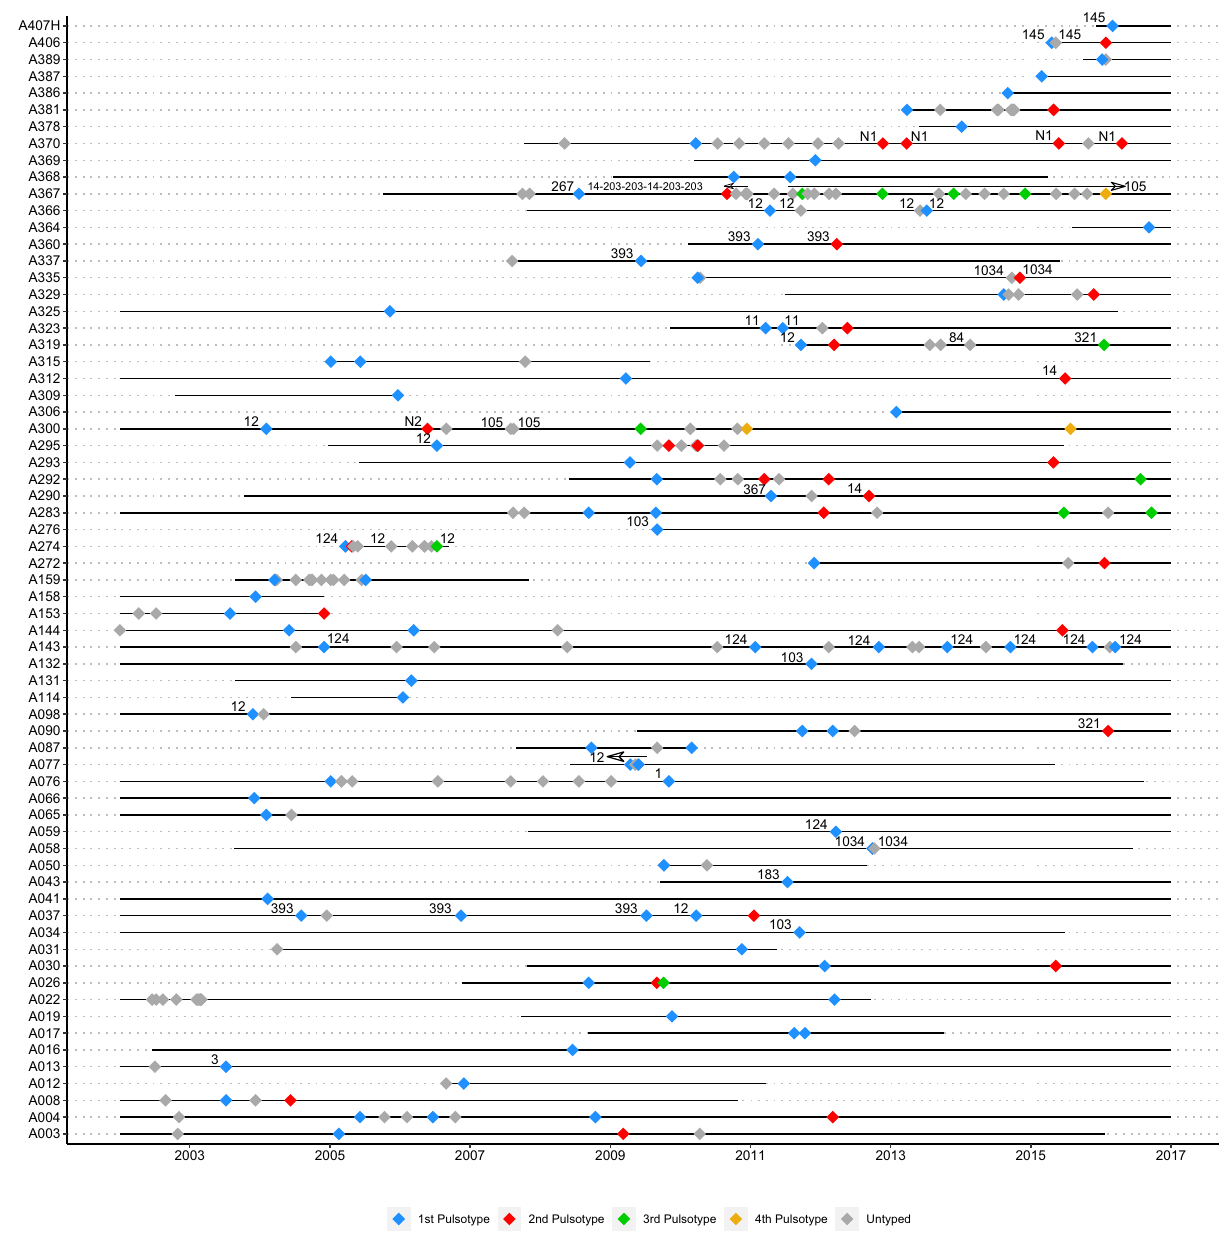
Figure 2. Timeline of pwCF with H. influenzae sputum isolated typed by PFGE. pwCF are represented on the Y-axis by patient ID (A###) and the X-axis represents study duration. Each diamond corresponds to a H. influenzae positive sputum culture. Colored diamonds represent cultures typed by PFGE, while grey diamonds represent untyped cultures. Colors correspond to sequential pulsotypes in each individual pwCF but have no meaning between pwCF. In most cases, untyped isolates represented serial isolates from patients in whom typed isolates provided a good indicator of strain diversity. STs of sequenced isolates (cultures) are labelled in black. Arrows indicate sequences of cultures belonging to indicated